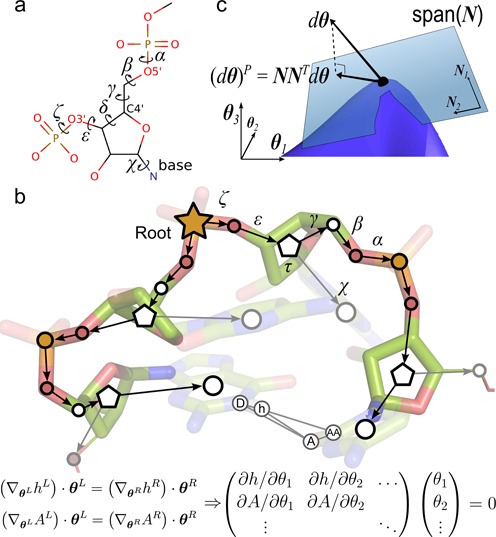
Kinematic representation of RNA. (a) A single nucleotide of RNA with its torsional degrees-of-freedom. (b) Edges in the directed spanning tree encode n torsional degrees-of-freedom \documentclass[12pt]{minimal}
\usepackage{amsmath}
\usepackage{wasysym}
\usepackage{amsfonts}
\usepackage{amssymb}
\usepackage{amsbsy}
\usepackage{upgreek}
\usepackage{mathrsfs}
\setlength{\oddsidemargin}{-69pt}
\begin{document}
}{}$\boldsymbol{\theta } = (\theta _1, \ldots , \theta _n)$\end{document} and vertices (circles) encode rigid bodies. Pentagons represent riboses, which have an additional internal degree-of-freedom governing their conformation (puckering). The hydrogen bond h-A closes a kinematic cycle, and is one of m distance constraints. As the position of the hydrogen atom h changes through perturbation of dihedral angles in the left branch of the tree, the new position of h should be matched by appropriate changes in the right branch, i.e. \documentclass[12pt]{minimal}
\usepackage{amsmath}
\usepackage{wasysym}
\usepackage{amsfonts}
\usepackage{amssymb}
\usepackage{amsbsy}
\usepackage{upgreek}
\usepackage{mathrsfs}
\setlength{\oddsidemargin}{-69pt}
\begin{document}
}{}$\left(\nabla _{{\boldsymbol{\theta }}^{\rm L}} h^{\rm L}\right)\cdot {\boldsymbol{\theta }}^{\rm L} = \left(\nabla _{{\boldsymbol{\theta }}^{\rm R}} h^{\rm R}\right)\cdot {\boldsymbol{\theta }}^{\rm R}$\end{document}. Similarly, a change in position of heavy atom A from the right tree should be matched by changes in the left tree. These instantaneous distance constraints define the 6m × n Jacobian matrix \documentclass[12pt]{minimal}
\usepackage{amsmath}
\usepackage{wasysym}
\usepackage{amsfonts}
\usepackage{amssymb}
\usepackage{amsbsy}
\usepackage{upgreek}
\usepackage{mathrsfs}
\setlength{\oddsidemargin}{-69pt}
\begin{document}
}{}$\boldsymbol{J}$\end{document}. (c) A schematic representation of the subspace of conformational space defined by the closure constraints. The subspace (blue surface) is highly nonlinear, but can be locally approximated by its tangent space, the null-space of \documentclass[12pt]{minimal}
\usepackage{amsmath}
\usepackage{wasysym}
\usepackage{amsfonts}
\usepackage{amssymb}
\usepackage{amsbsy}
\usepackage{upgreek}
\usepackage{mathrsfs}
\setlength{\oddsidemargin}{-69pt}
\begin{document}
}{}$\boldsymbol{J}$\end{document} (translucent blue plane).